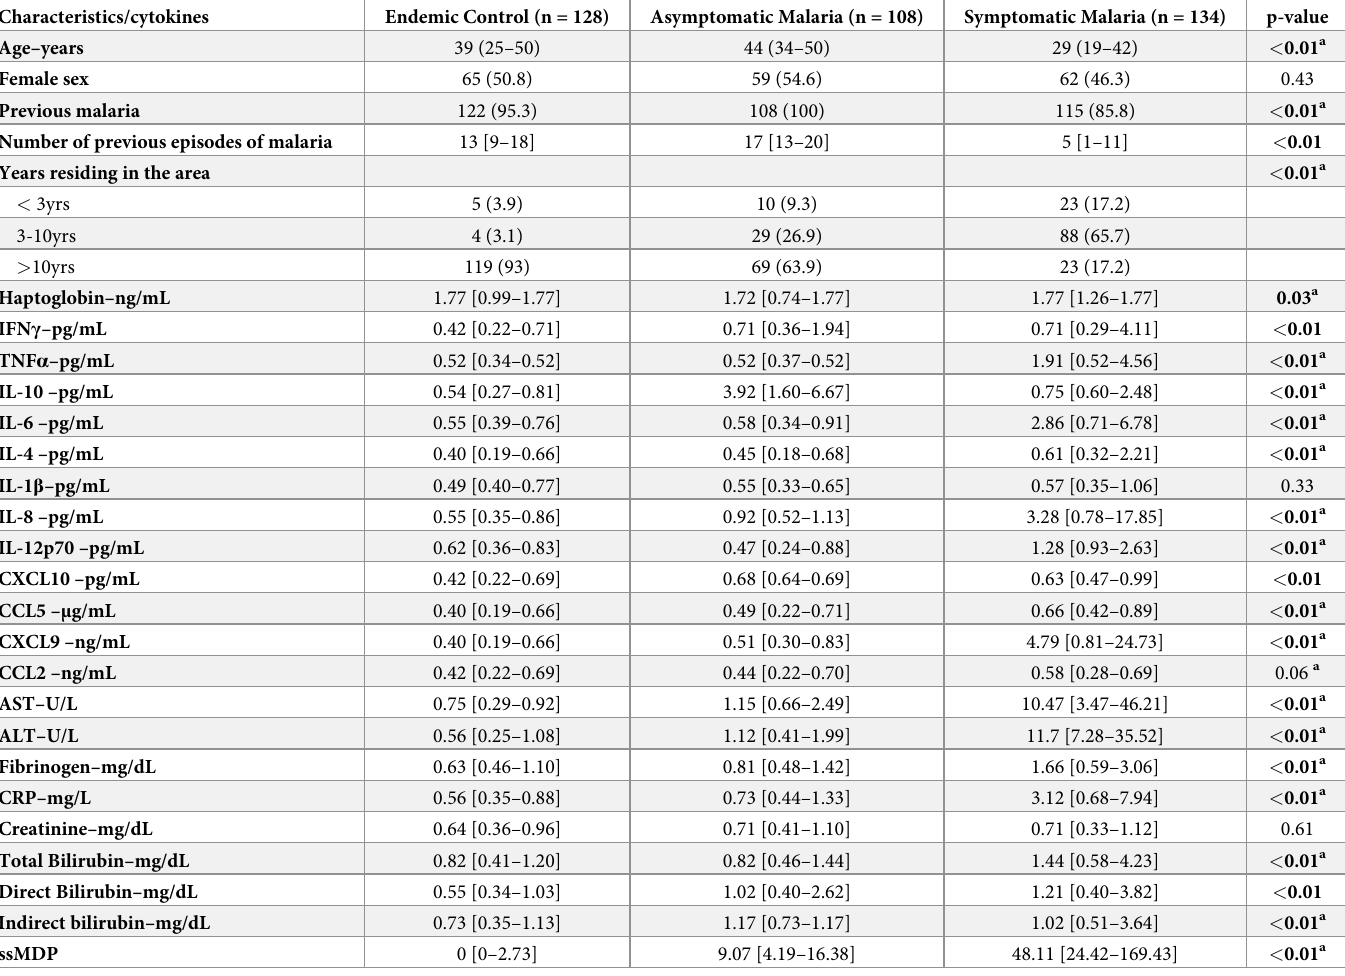
Table 1. Characteristics of the study